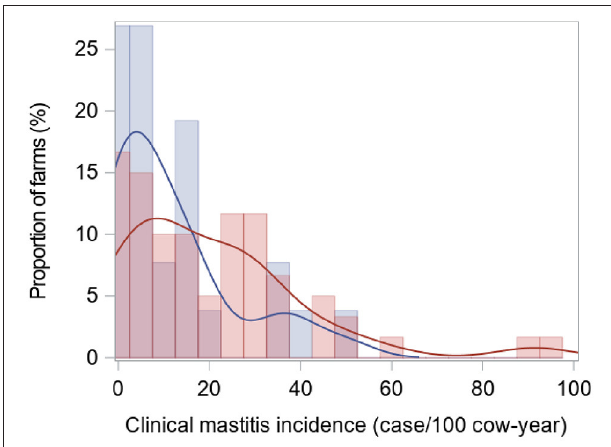
FIGURE 2 | Clinical mastitis incidence distribution estimated using a period at risk extending from start to end of the study in a study comparing 26 farms using recycled manure solids bedding (blue) and 60 farms using straw bedding (red).